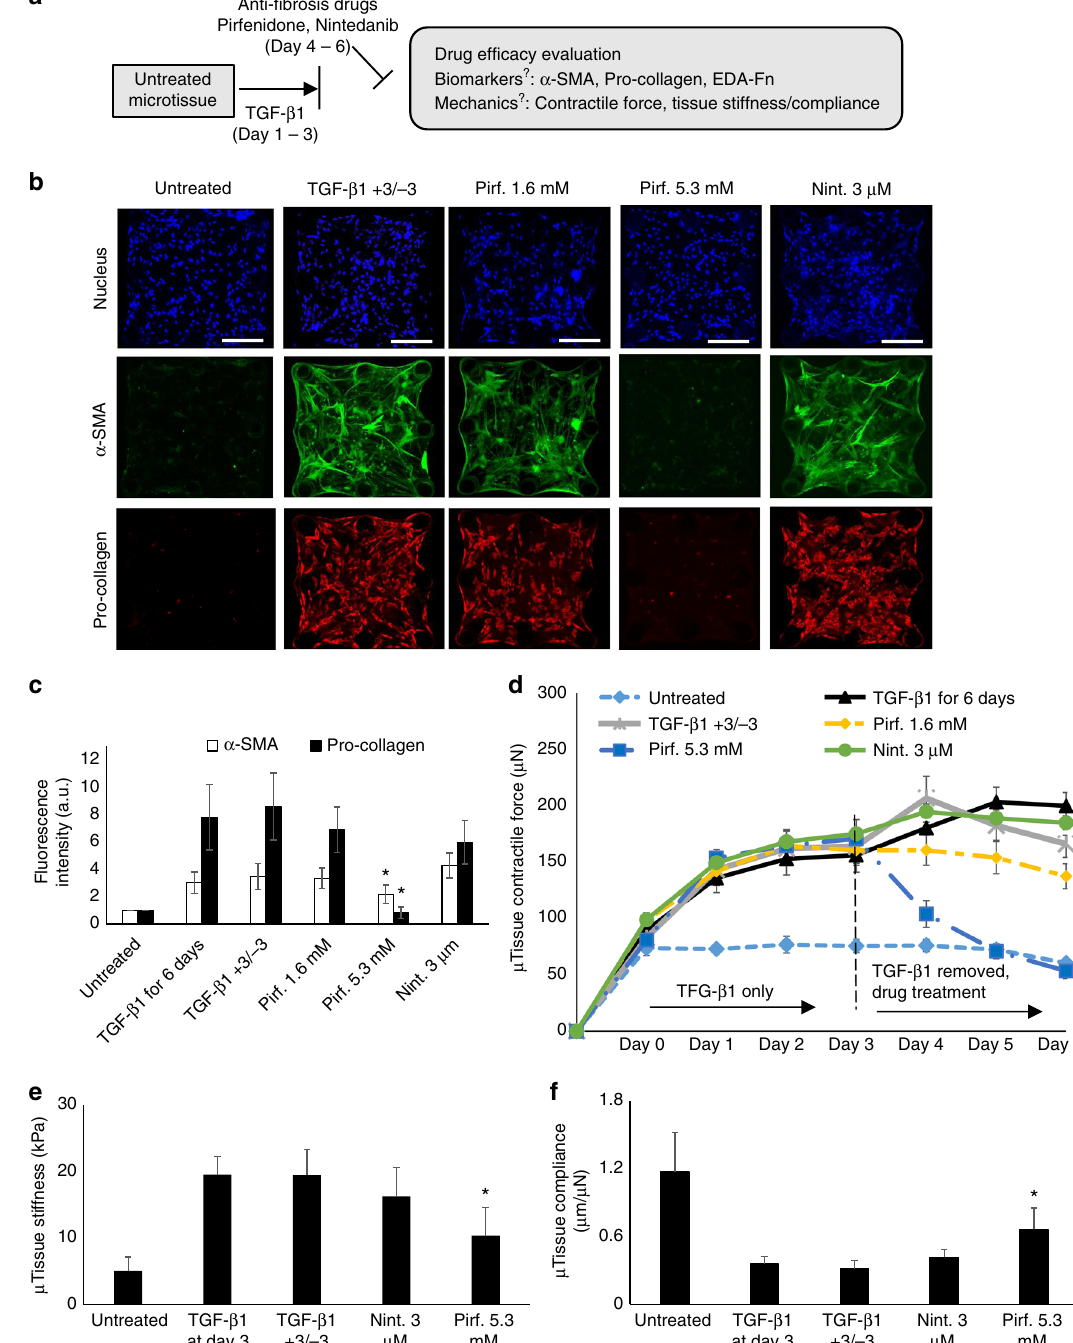
Fig. 6 Anti- fi brosis drug ef fi cacy under therapeutic treatment. a Overview of the strategy for therapeutic anti- fi brosis treatment and evaluation of the anti- fi brosis ef fi cacy based on the measurement of biomarker expression and tissue mechanical properties. Initial fi brosis progression was induced using TGF- β 1 in the fi rst three days and anti- fi brosis treatments were applied from day 3 to 6 without the presence of TGF- β 1. b Representative immuno fl uorescence images of nuclei, α -SMA and pro-collagen of microtissues at day 6, with or without therapeutic anti- fi brosis treatments. TGF- β 1 + 3/ − 3 represents 3 days of TGF- β 1 treatment followed by 3 days of normal culture condition without TGF- β 1. Scale bar is 200 µ m. c Plot of tissue-level fl uorescence intensity of α - SMA and pro-collagen at day 6. d Time-lapsed measurement of microtissue contractile force. e Plot of microtissue stiffness measured by tensile test at day 6. f Plot of microtissue compliance measured at day 6. Data are reported as the mean ± SD. n ≥ 10; * P < 0.05 when compared to TGF- β 1-treated condition. Statistical signi fi cance was determined by one-way ANOVA with Tukey